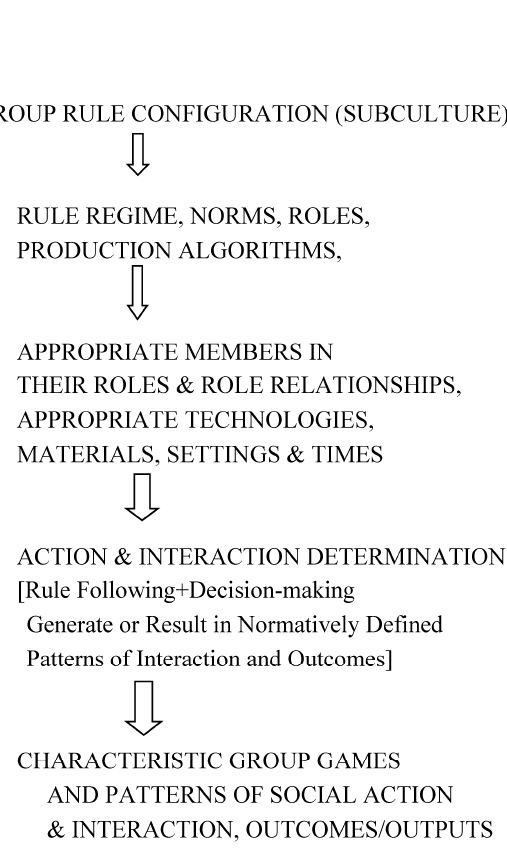
Figure 2. Group Rule Configuration and the Structuration of Group Games and Interactions.